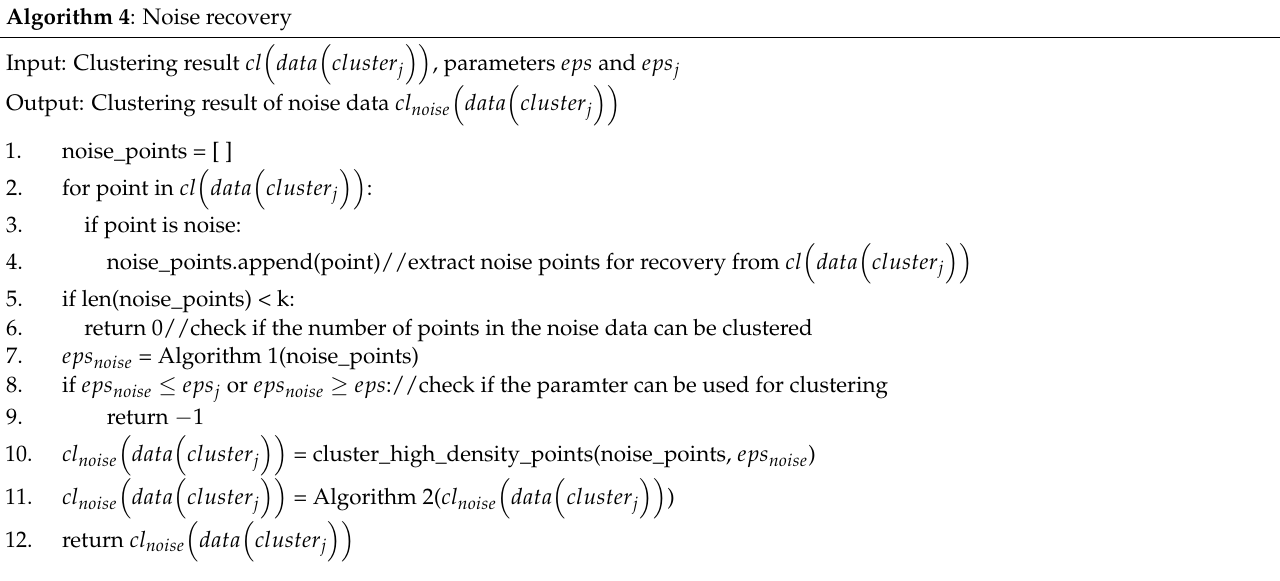
Algorithm 4 : Noise